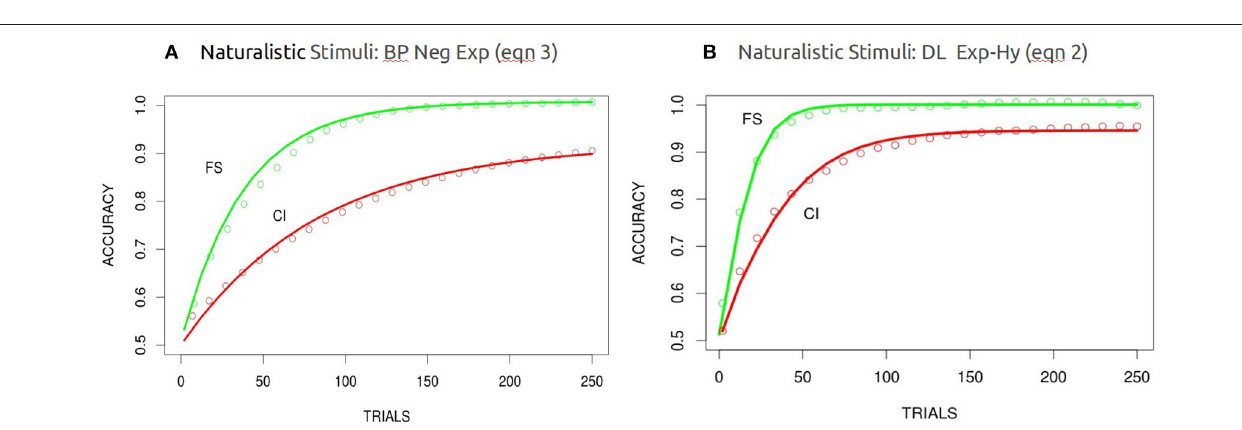
FIGURE 6 | Modeling of the FS and CI conditions with the high dimensional naturalistic stimuli for BP (A) and DL (B) averaged over 100 runs. Best fitting functions were the negative exponential functions for BP and the hyperbolic exponential functions for DL (overlaid in red). These are binned averages over blocks of 100, there were a total of 250 weight